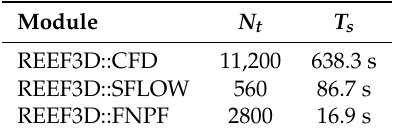
Table 4. Comparison of total number of cells N t and simulation time T s in seconds for the simulation of progressive 2nd-order Stokes wave using the three